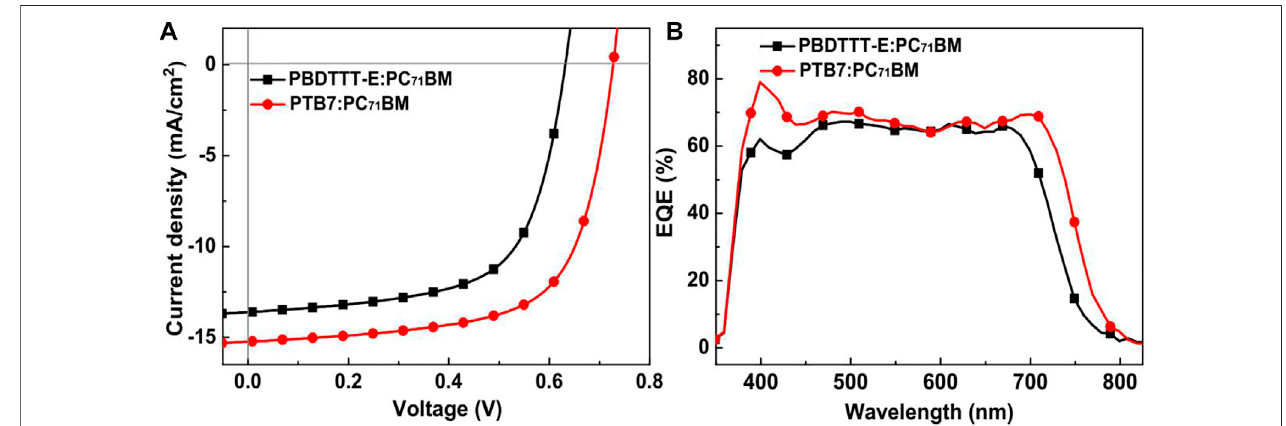
FIGURE2|(A) Averaged J – V curvesofPBDTTT-E:PC 71 BMandPTB7:PC 71 BMsolarcells.The J – V characteristicswereaveragedfrom10cells. (B) EQEcurvesof PBDTTT-E:PC 71 BM and PTB7:PC 71 BM devices.